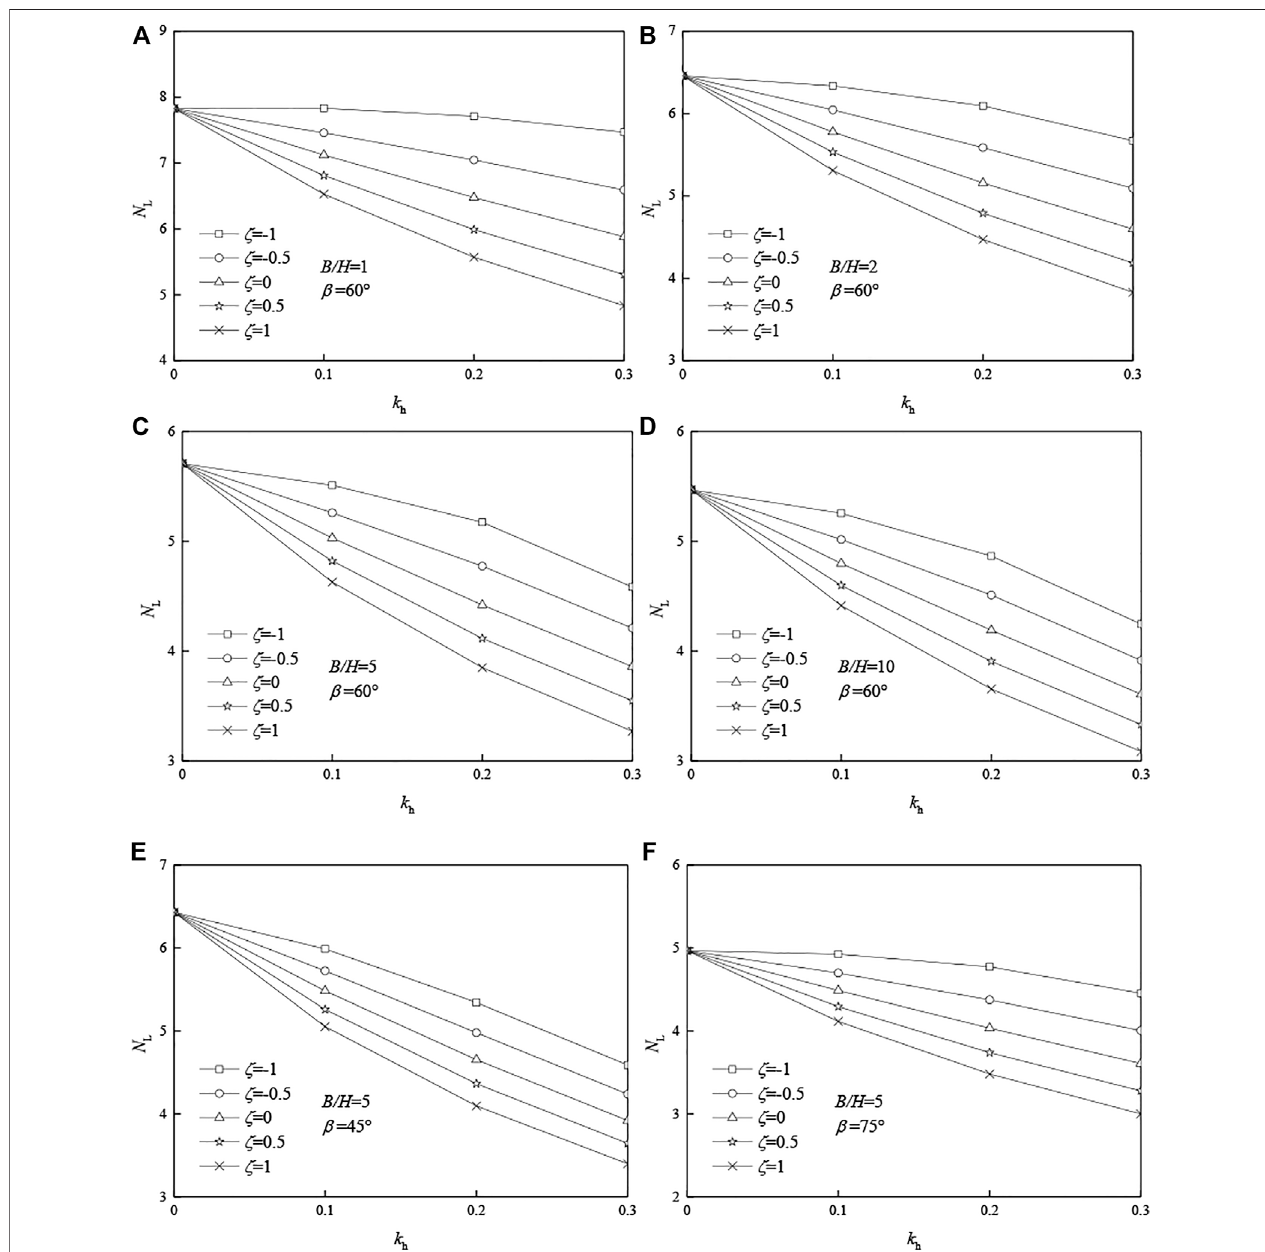
FIGURE4| Effectsofthehorizontalseismiceffectcoef fi cient k h onstabilityfactor N L: (A) B/H (cid:1) 1, β (cid:1) 60 ° ; (B) B/H (cid:1) 2, β (cid:1) 60 ° ; (C) B/H (cid:1) 5, β (cid:1) 60 ° ; (D) B/H (cid:1) 10, β (cid:1) 60 ° ; (E) B/H (cid:1) 5, β (cid:1) 45 ° ; (F) B/H (cid:1) 5, β (cid:1) 75 ° .